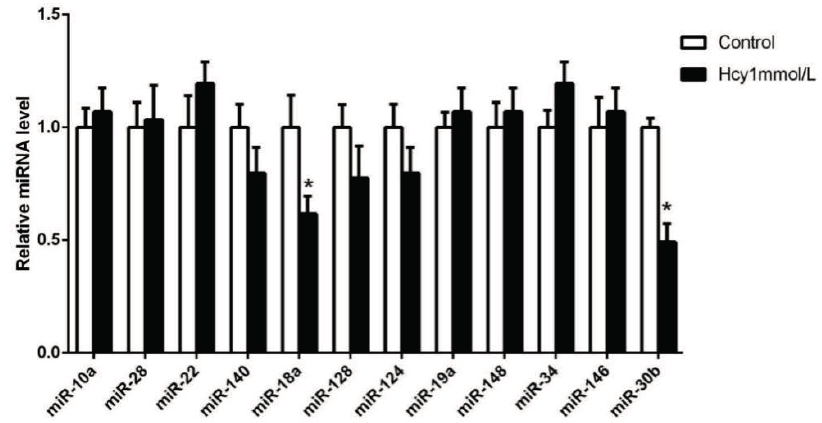
Figure 3. The expression of microRNAs in apoptosis Hcy-induced in HCAECs. The time of treatment was 24 h. Compared with the control group, * p < 0.05, n = 3 in each group. 2.3. Overexpression of miR-30b Inhibits the Apoptosis Induced by Hcy in HCAECs